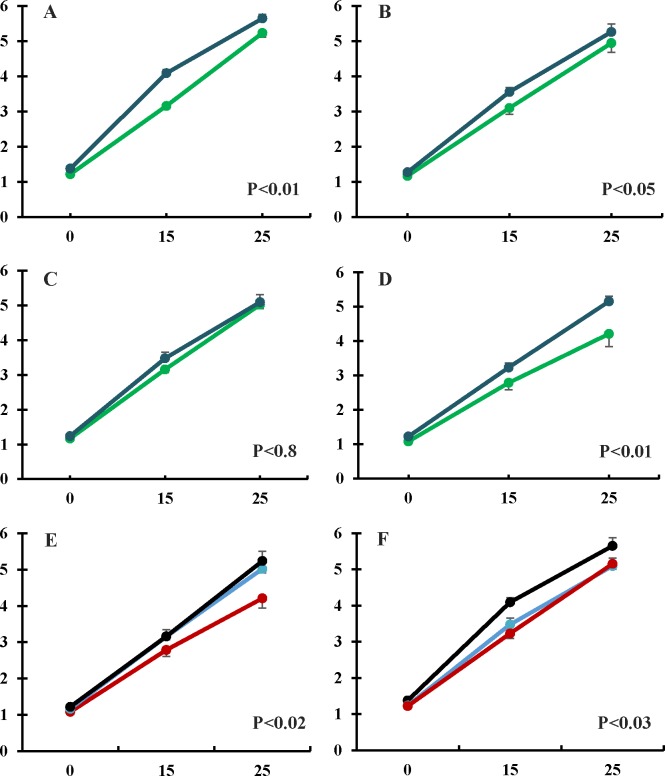
Changes in body-weight (Kg/day) of piglets throughout the lactation period.The panel A represents total differences between groups of treatment. Panels B, C and D represent between-treatments differences considering litter size (2–6, 7–8 and 9–10 piglets, respectively). Panels E and F represent within-treatment differences considering litter size in control and treated groups, respectively. Dark blue: Hydroxytyrosol group. Green: Control group. Red: 9–10 piglets/litter. Light blue: 8–7 piglets/litter. Black: 2–6 piglets/litter.